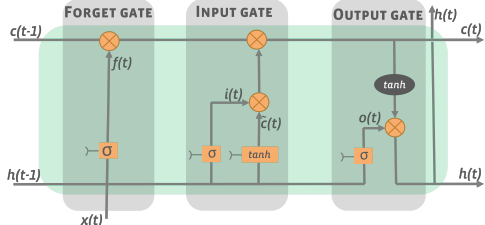
Figure 5. LSTM architecture (adapted from [73]).